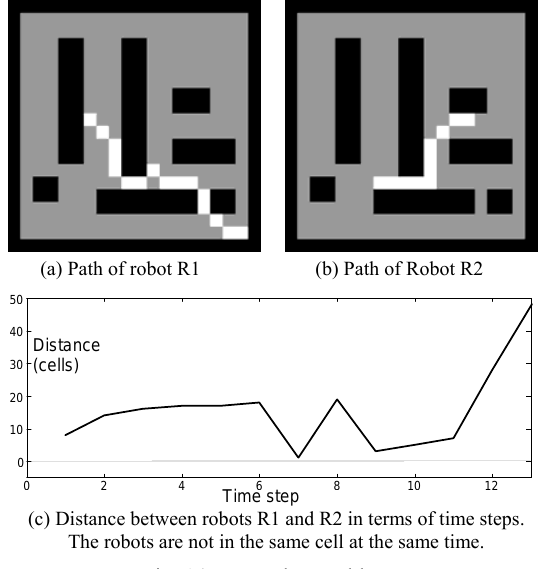
(c) Distance between robots R1 and R2 in terms of time steps. The robots are not in the same cell at the same time. Fig. 14. Two robot problem